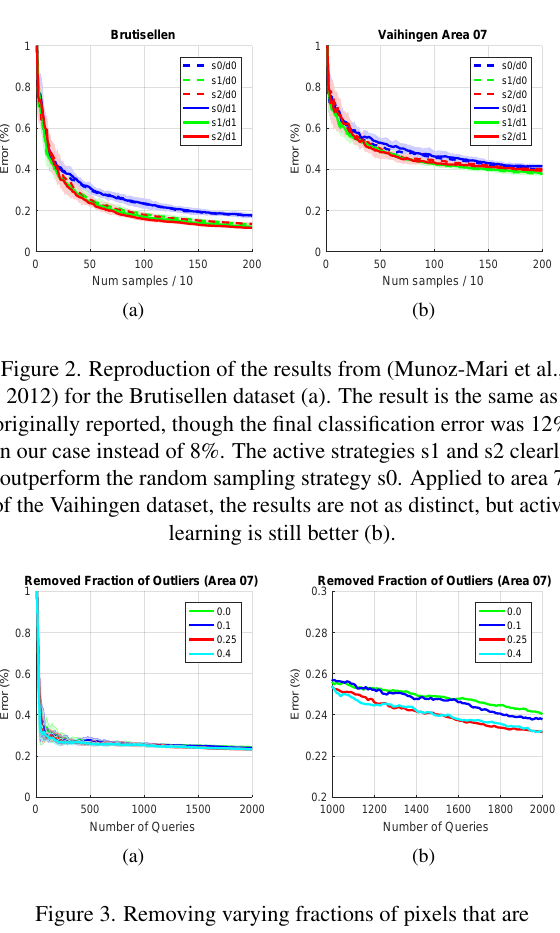
Figure 5. Varying the number of bisections in the hierarchical clustering step leads to no significant change (less than 0.4 percent points) in classification